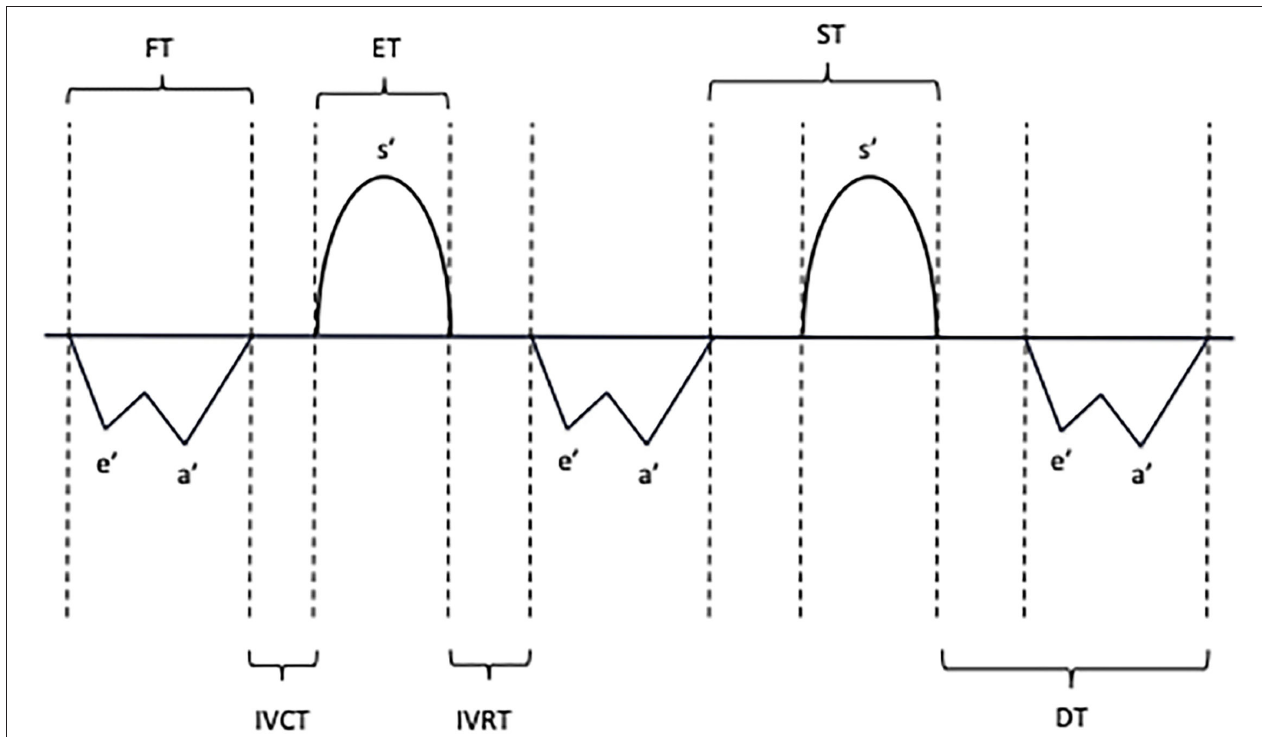
FIGURE 2 | Schematic representation of systolic and diastolic myocardial velocities and time interval measurements with pulsed-wave tissue Doppler. S’, Systolic velocity; E’, Early diastolic velocity; A’, Late diastolic velocity; IVCT, Isovolumic contraction time; IVRT, Isovolumic relaxation time; FT, Filling time; ET, Ejection time; ST, Systolic time; DT, Diastolic time.